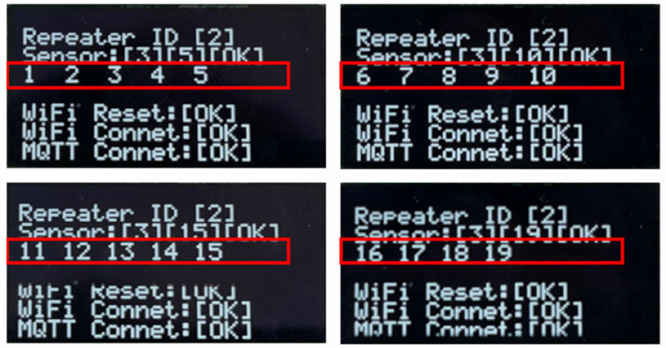
Figure 16. LCD display